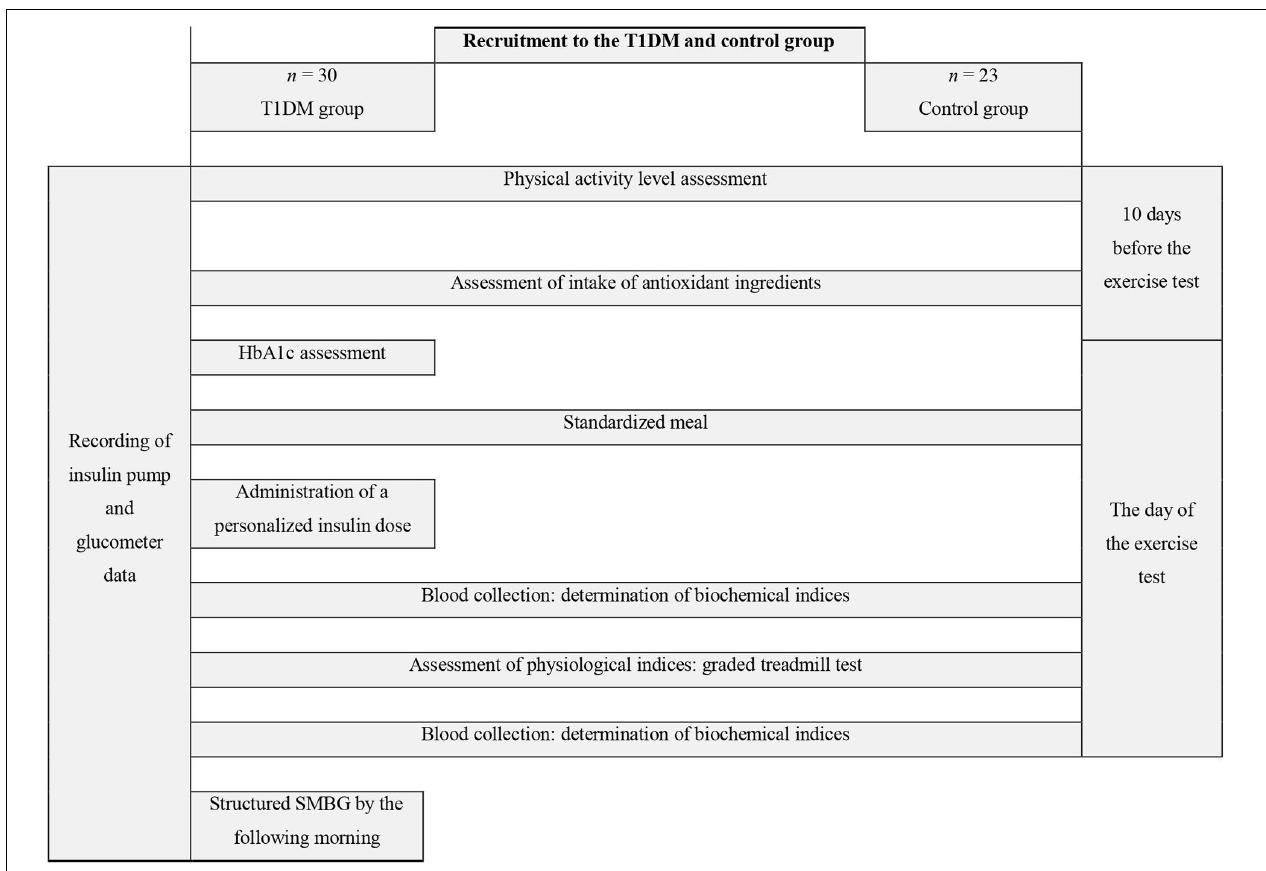
FIGURE 1 | Study design diagram. T1DM, type 1 diabetes mellitus; HbA1c, glycated hemoglobin; SMBG, self-monitoring of blood